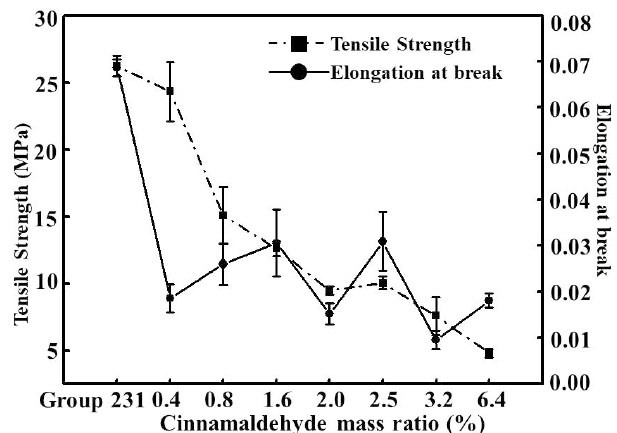
Figure 3. Mechanical properties of CS / corn starch films with di ff erent cinnamaldehyde ratios ( p < 0.05).